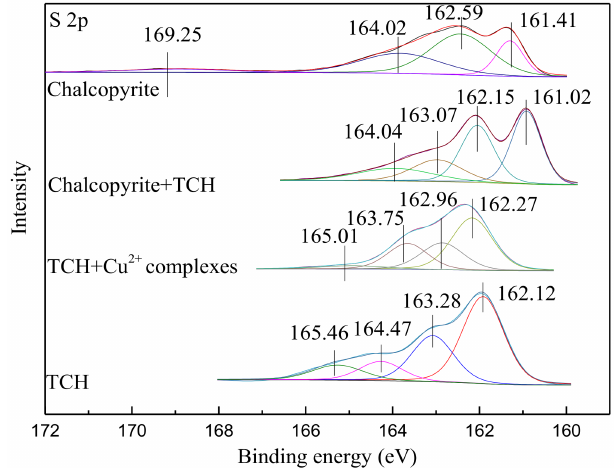
Figure 7. S 2p spectra of TCH, TCH–Cu 2+ , and chalcopyrite before and after